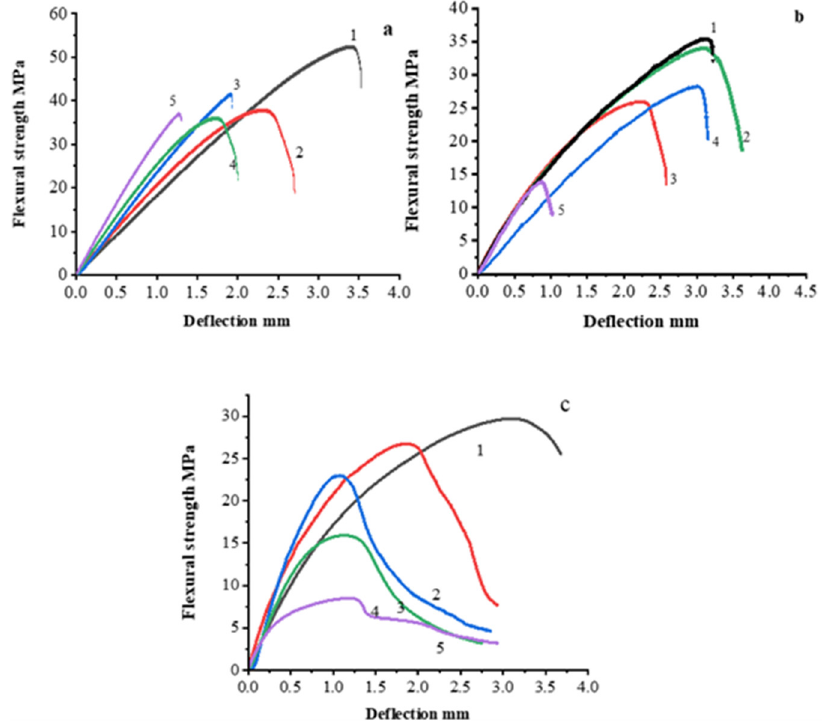
Figure 8. Flexural test of PSU based composites filled with 30 (1), 40 (2), 50 (3), 60 (4) and 70 (5) wt.% of AG ( a ), NG ( b ) and EG ( c ).